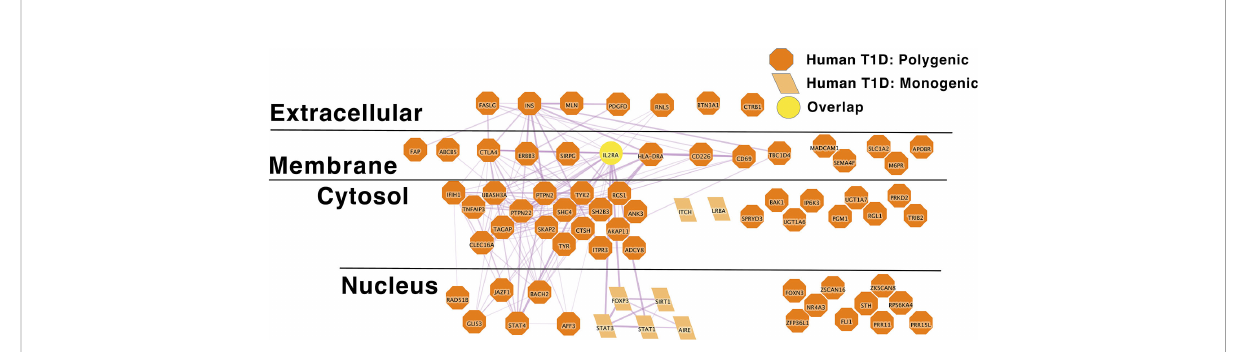
FIGURE 2 IL2RA is the link between Monogenic and Polygenic human type 1 diabetes risk gene networks; light orange parallelogram – human monogenic autoimmune type 1 diabetes gene; dark orange octagon – human polygenic autoimmune type 1 diabetes gene; Yellow circles – overlapping genes.Downloadable/Interactive network diagram can be found at: